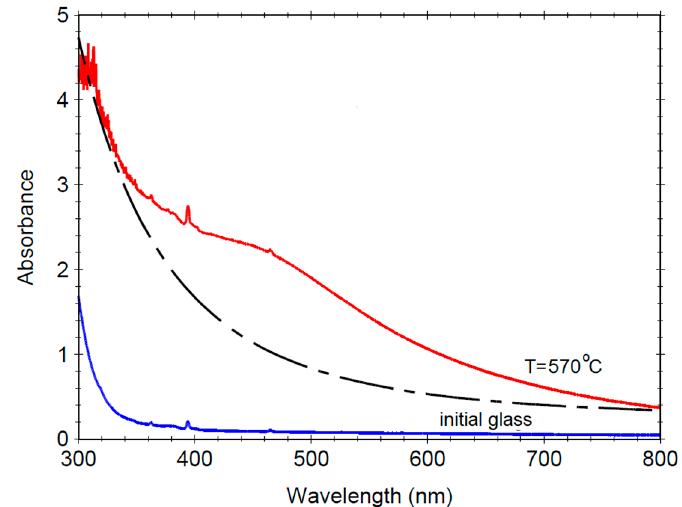
Figure 4. Optical absorption spectra of initial Eu-doped chloroborate glass and glass-ceramic after 570 °C annealing; the doted curve represents the λ − 4 Rayleigh scattering dependence curve .